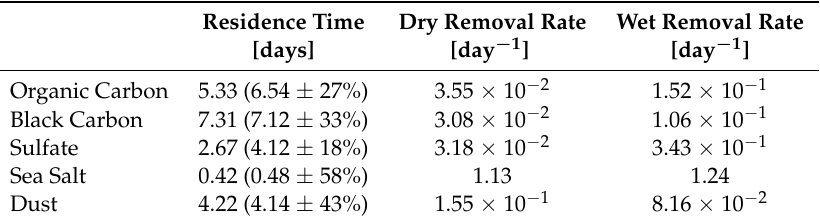
Table 2. Residence and removal rates of aerosols in G5NR. The residence times in parenthesis are multi-model means and standard deviations from the AeroCom project reported in